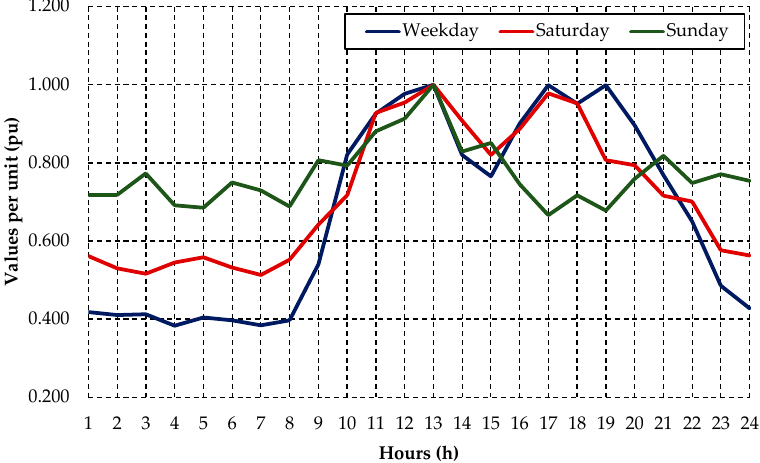
Figure 4. Typology of the daily load profile for a commercial customer. Source: The authors.